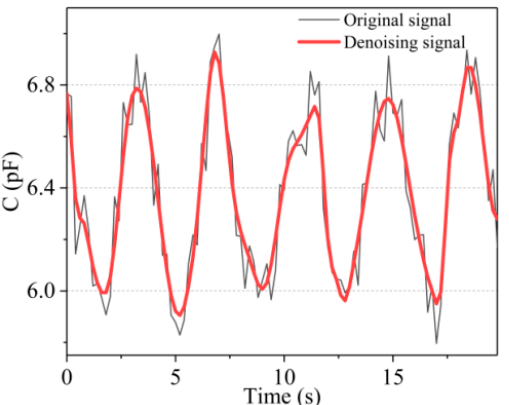
Figure 14. Denoising effect of wavelet threshold denoising method on breathing signals collected in the state of standing still.